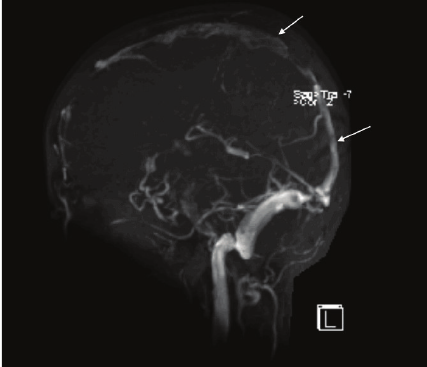
Figure 7: MR venogram showing complete resolution of the thrombus and reperfusion of the superior sagittal sinus